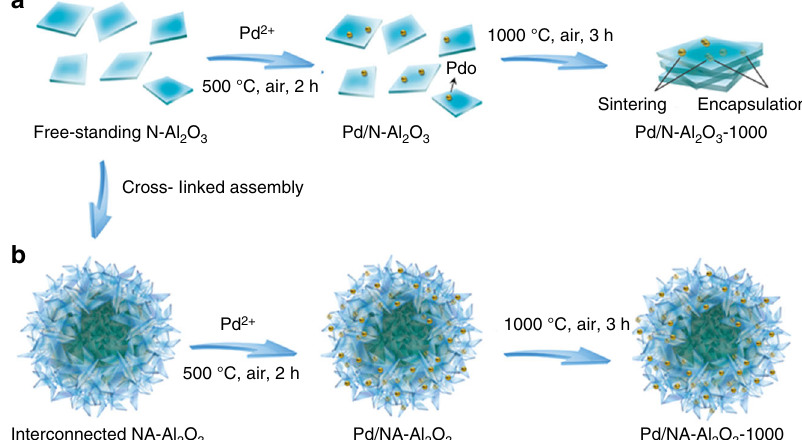
Fig. 1 Illustration of stabilization of Pd active phases . a Pd active phases stabilized by N-Al 2 O 3 in air at 1000 °C. b Pd active phases stabilized by NA-Al 2 O